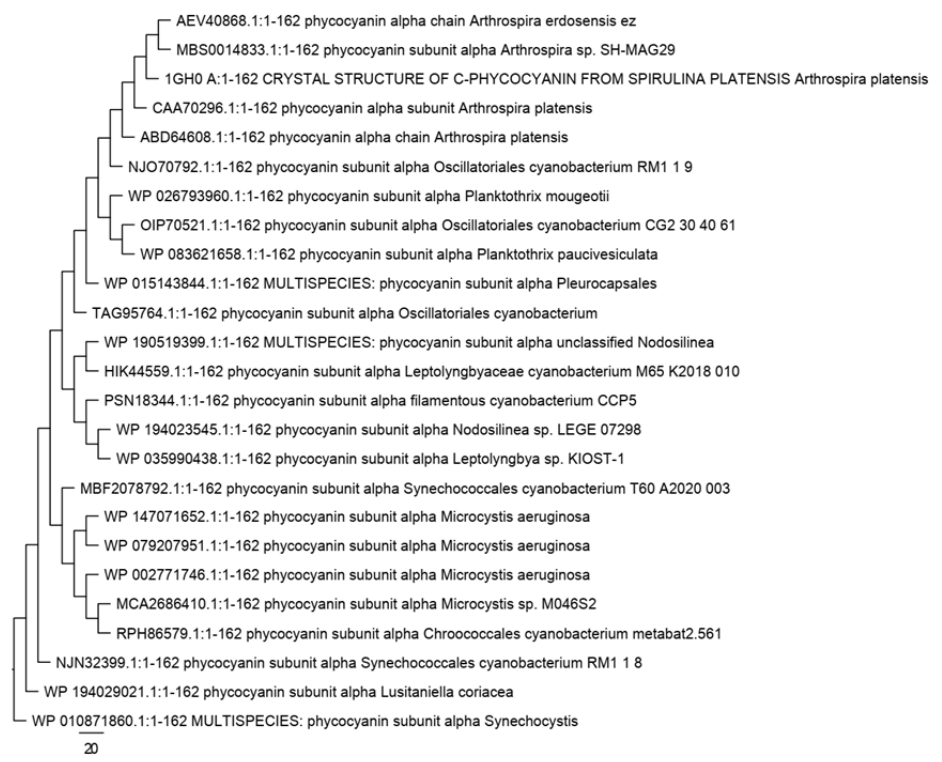
Figure 8. Phylogenetic tree of amino acid sequences of phycocyanin subunit alpha of 25 cyanobacterial species, including A. platensis strains and variants. The branching order and score were calculated by MEGA11 and visualized by FigTree 1.4.2. Table 5. The frequencies of amino acids (%) in phycocyanin subunit alpha protein sequences of 25 cyanobacterial species, including A. platensis strains and variants, as calculated using MEGA11.